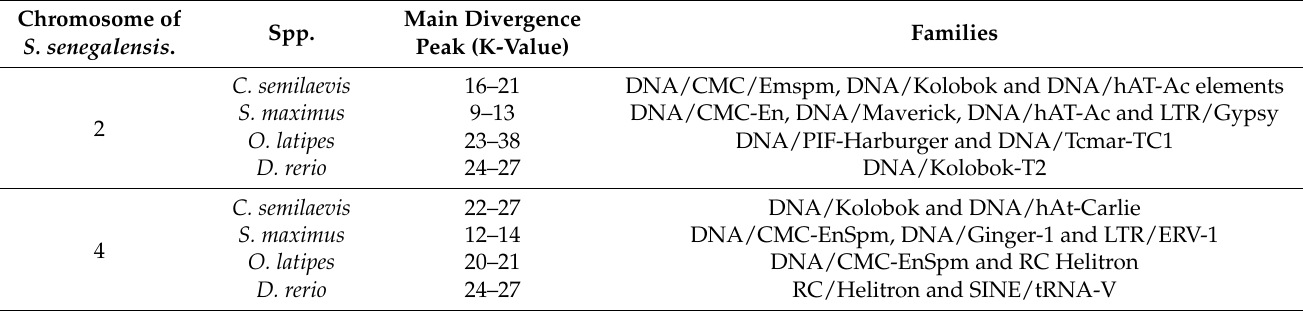
Table 3. Summary of TEs divergence analysis carried out between syntenic regions of Cynoglossus semilaevis , Scophthalmus maximus , Oryzias latipes , and Danio rerio with Solea senegalensis in chromosomes 2 and 4. Chromosome of S. senegalensis